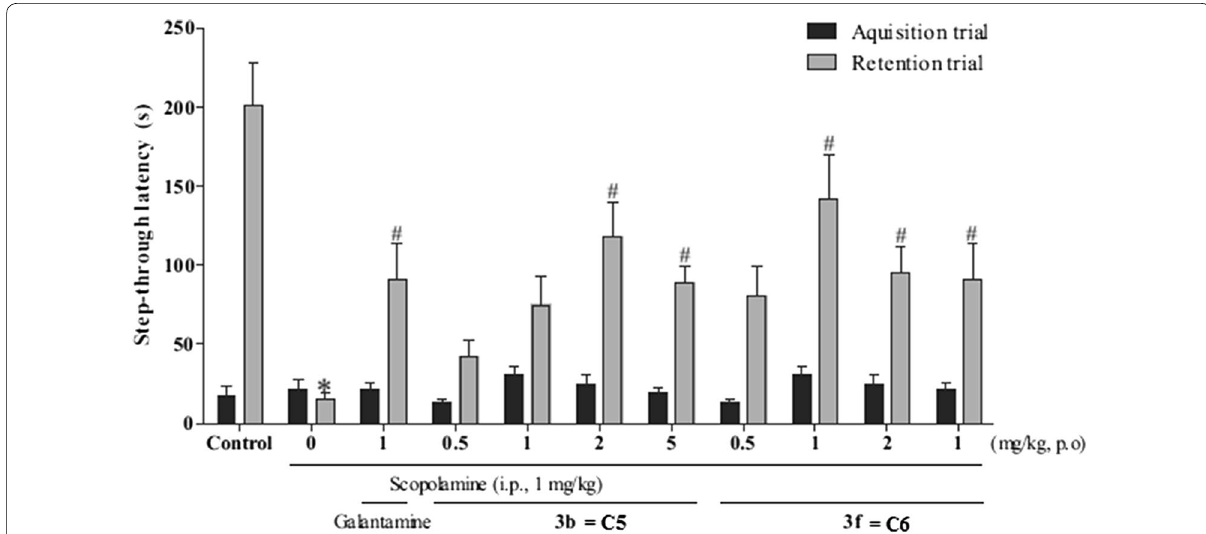
Fig. 9 Effects of C6 , C7 , and galantamine on the passive avoidance task in scopolamine-induced memory deficit model. *P < 0.05 versus vehicle-treated controls. # P < 0.05versus scopolamine-treated group. Data are expressed as mean